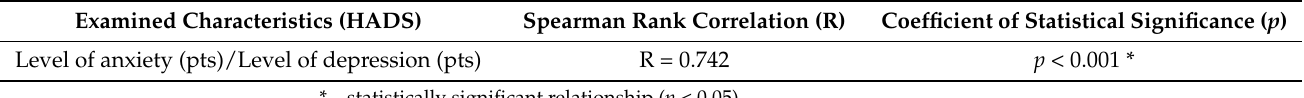
Table 5. Correlation between the level of anxiety and depression (Spearman rank correlation). Examined Characteristics (HADS)